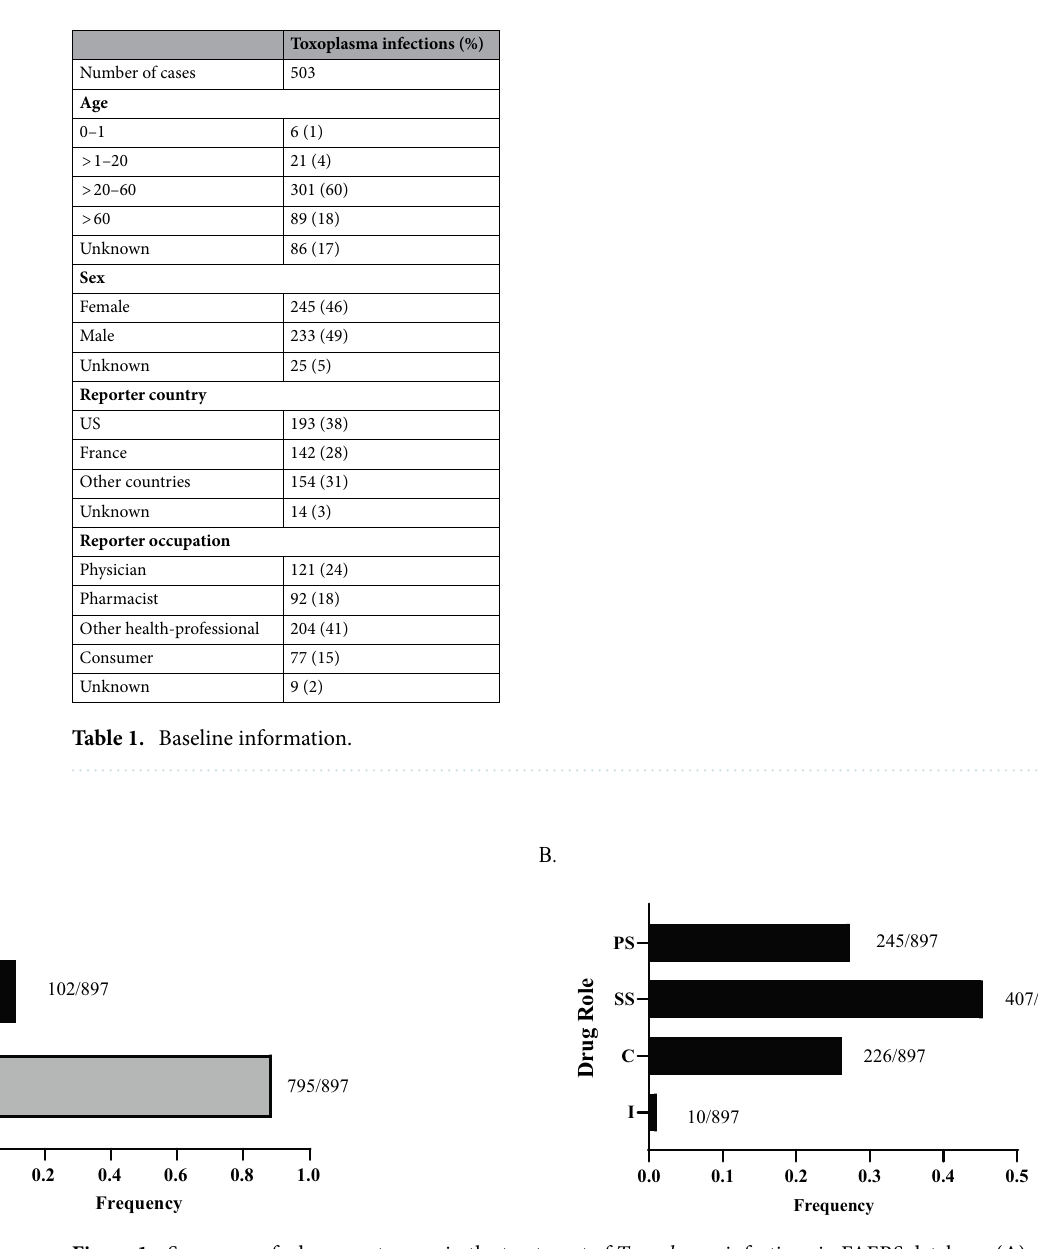
Figure 1. Summary of adverse outcomes in the treatment of Toxoplasma infections in FAERS database. ( A ) Summary of adverse outcomes from the cases treating Toxoplasma infections. ( B ) Specification of the role of the drug in the adverse outcome as listed in FAERS